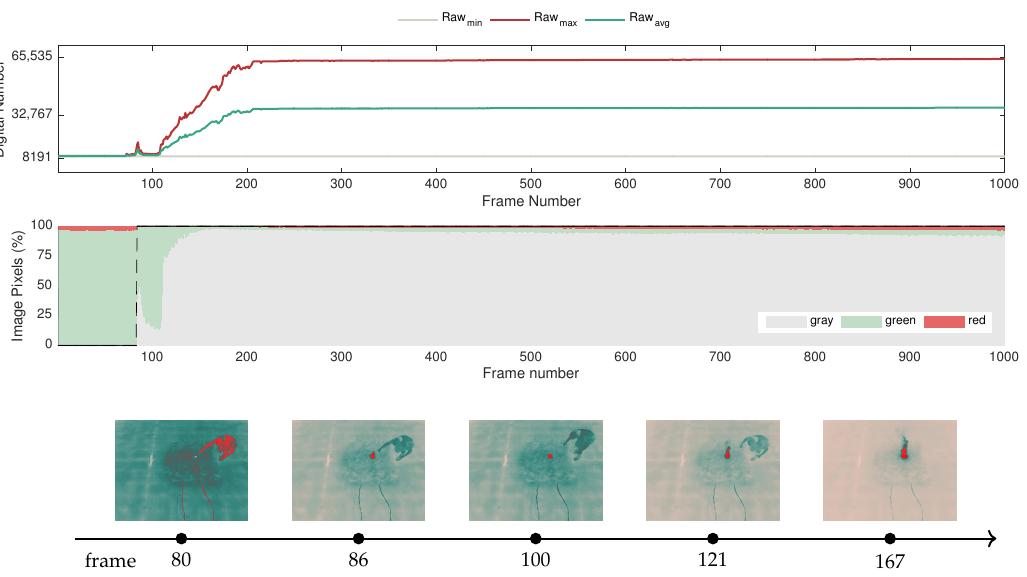
Figure 16. Feature-based representation of the sensor response of the thermal camera to a fire ignition: raw features ( top ); color features ( center ); sample frames ( bottom